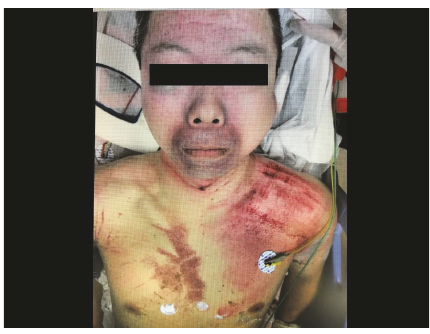
Figure 2: Patient’s appearance. A physiological examination revealed multiple petechiae on the patient’s face, and strangulation marks with subcutaneous hemorrhage on his neck and upper